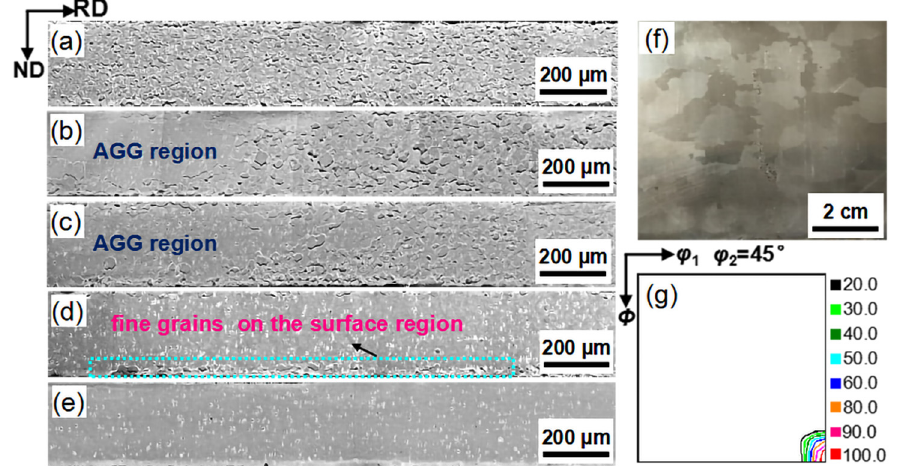
Figure 6. Microstructure evolution with increasing final annealing temperature to: ( a ) 825 °C, ( b ) 850 °C, ( c ) 875 °C, ( d ) 900 °C, and ( e ) 925 °C, as well as the ( f ) macrostructure and ( g ) constant φ 2 = 45° section of ODF after annealing at 950 °C.